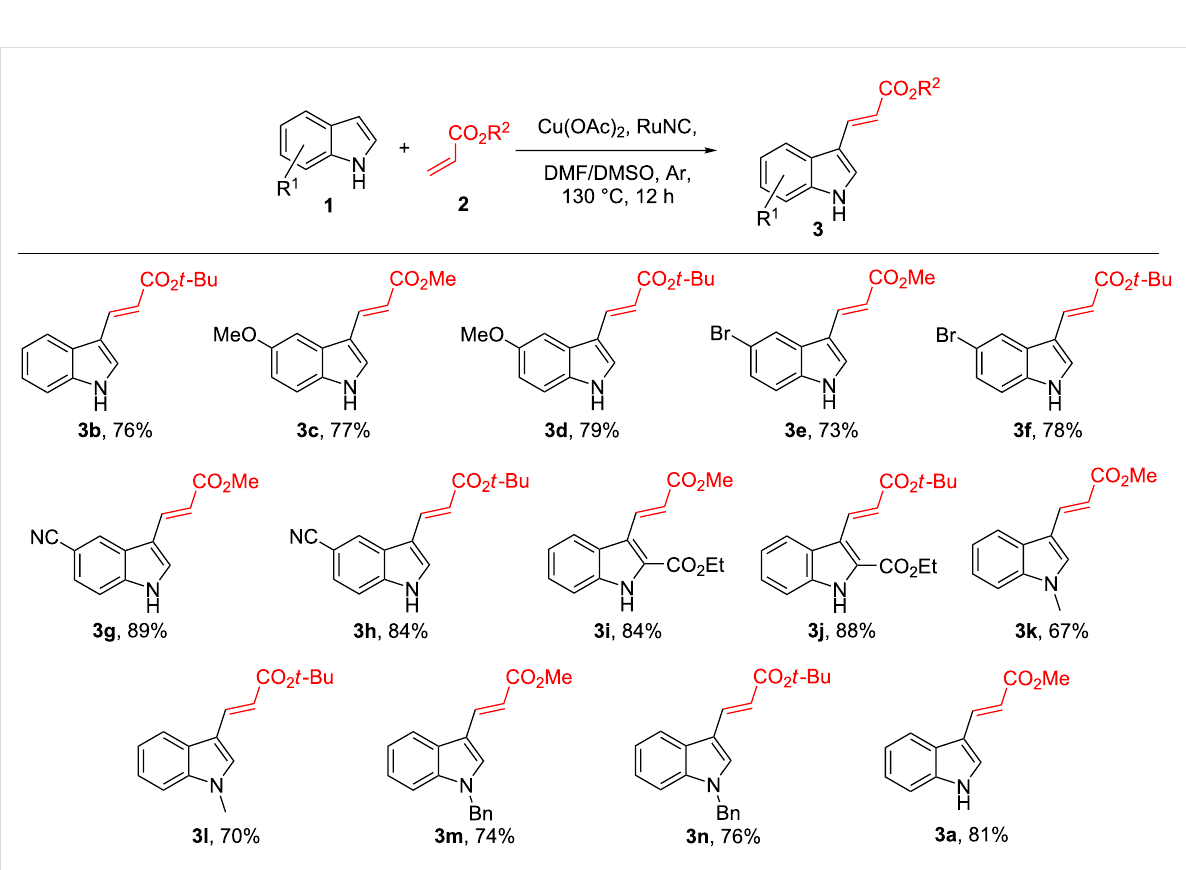
Scheme 2: Substrate scope for the C–H alkenylation of the indoles 1 . Reaction conditions: 1 (1 mmol), 2 (2 mmol), oxidant (1.8 mmol), DMF/DMSO, 9:1, v/v (5 mL), RuNC (3 mg), Ar, 130 °C, 12 h. All yields are isolated